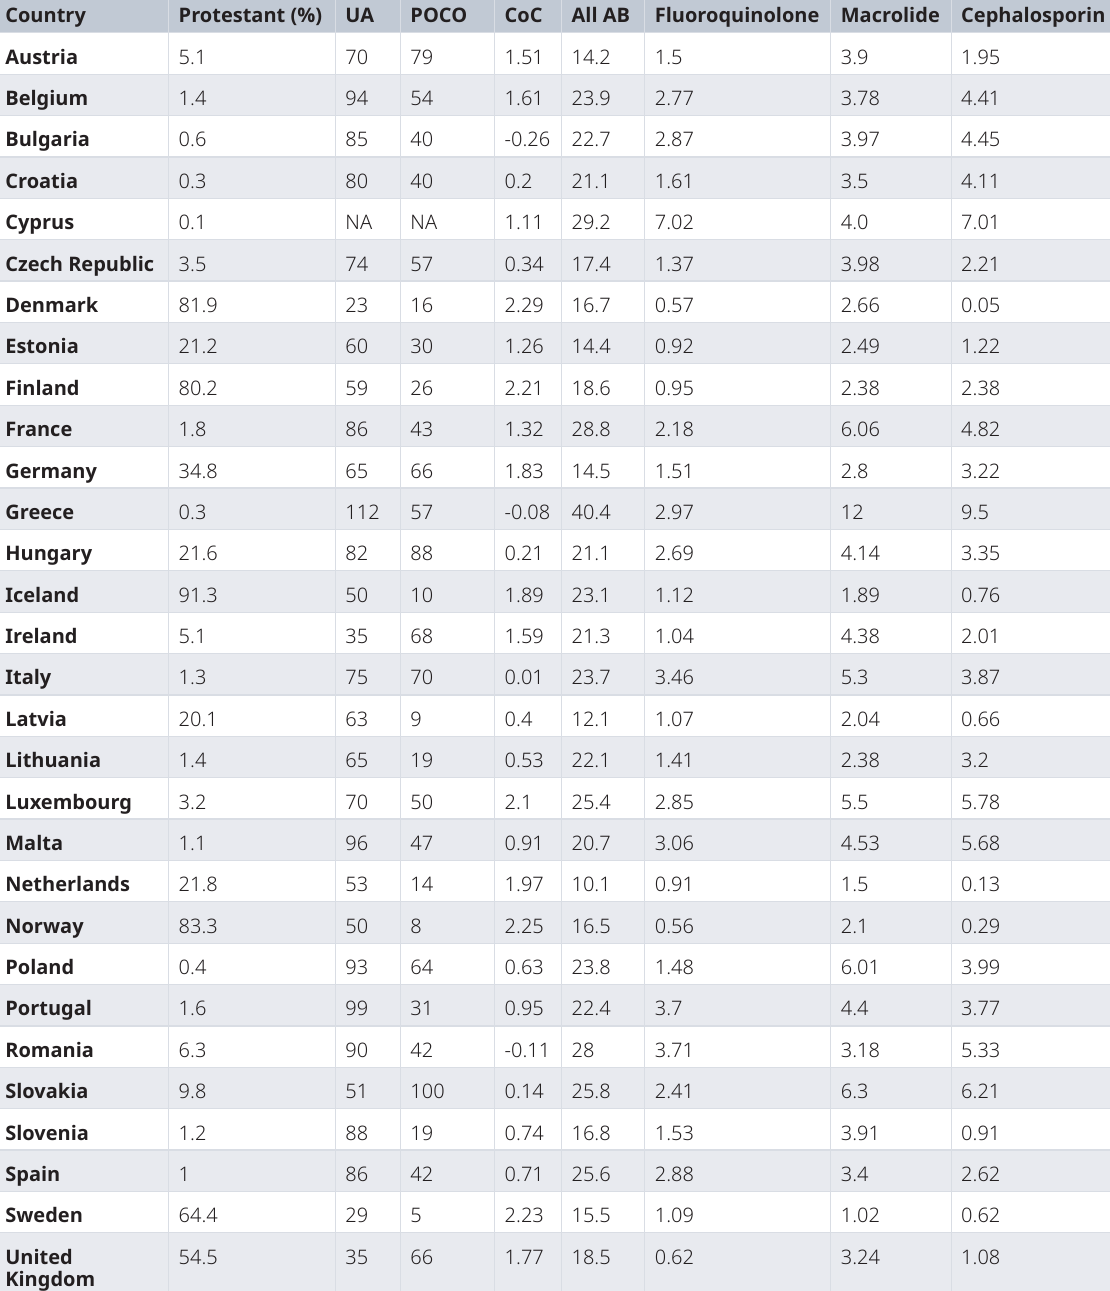
Table 1. National antimicrobial consumption (defined daily doses/1000 individuals/day), Uncertainty Avoidance (UA) Index, Power oriented vs. cooperation oriented (POCO) Index, Percent Protestant in 30 European countries.